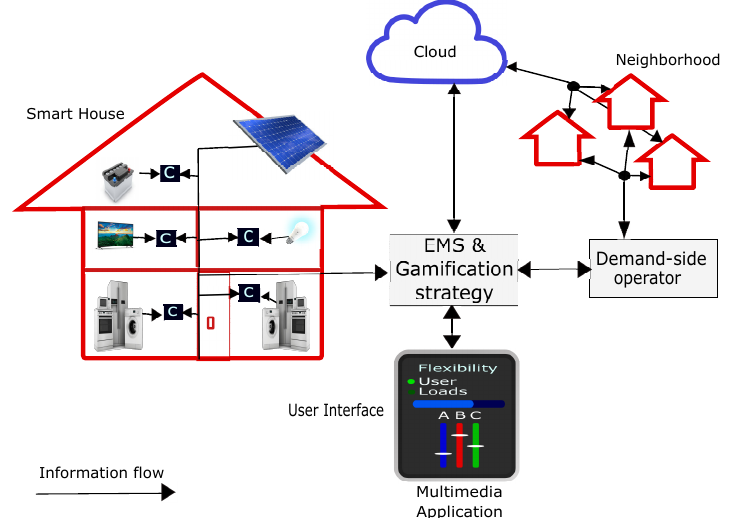
Figure 1. EMS and gamification strategy